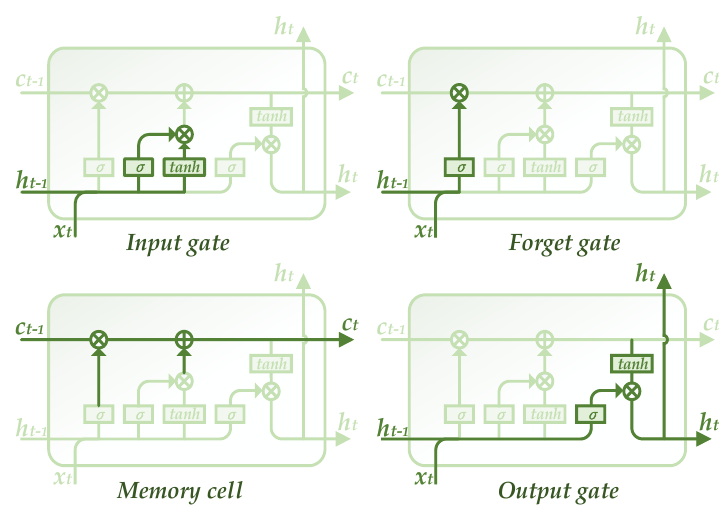
Figure 6. T he structure of a long short-term memory (LSTM) block. Figure 6. The structure of a long short-term memory (LSTM)